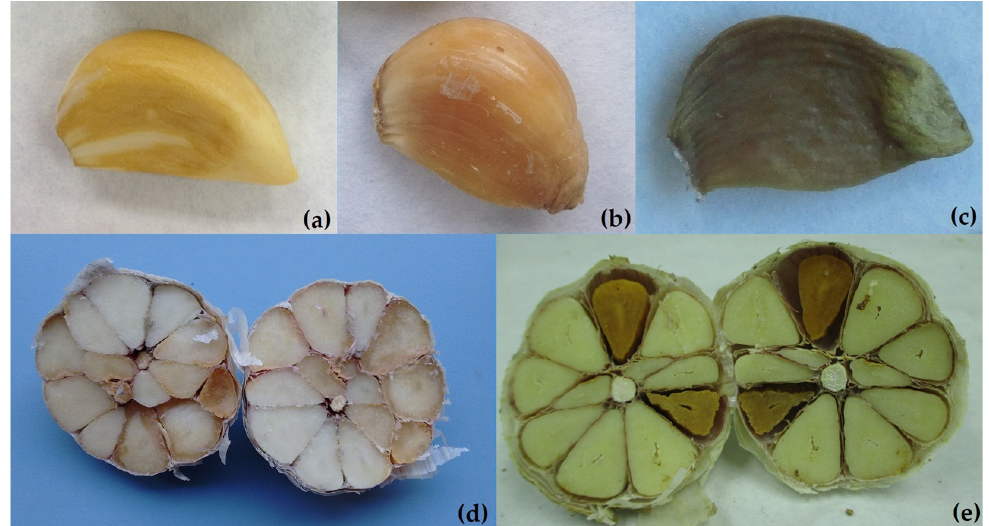
Figure 3. Garlic cloves and bulbs affected by other disorders easily confused with dry rot: ( a ) damage caused by eriophyid mites; ( b ) physiological disorder of waxy breakdown; ( c ) clove affected with waxy breakdown and dry rot; ( d ) bulb affected with dry rot caused by F. proliferatum ; ( e ) bulb affected with waxy breakdown.